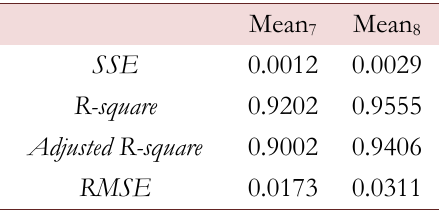
Table 11: Goodness-of-fit statistics of Mean 7 -Mean 8